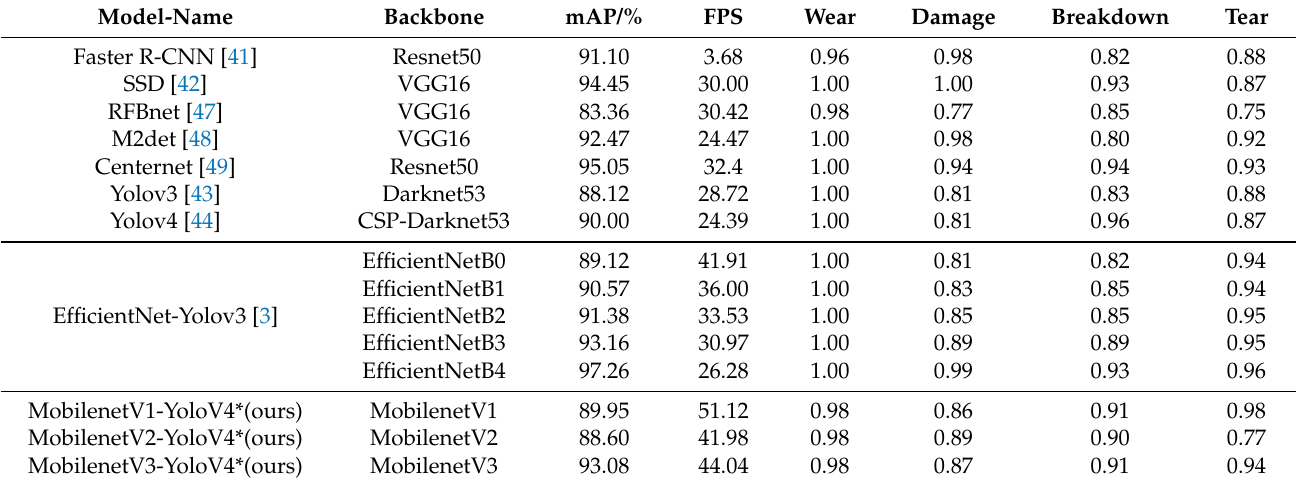
Table 2. The performance of various algorithms on the dataset. (*: Channel number scaling factor α =